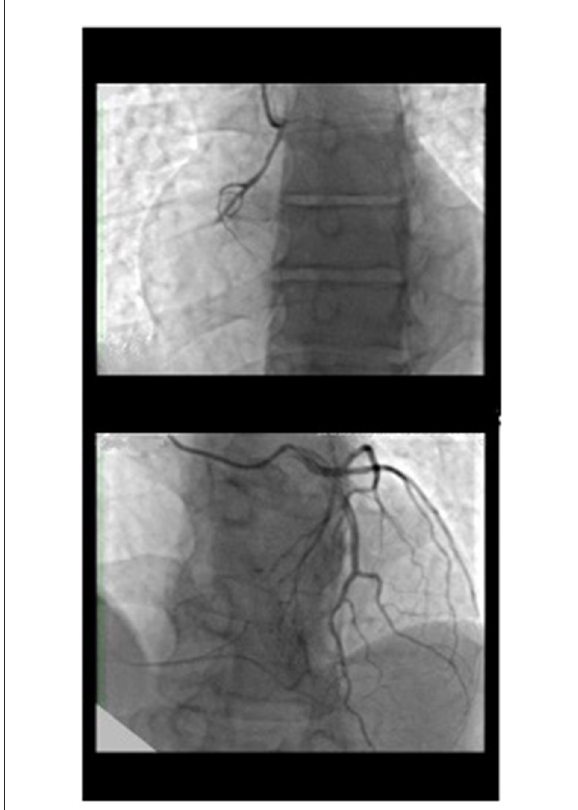
FIGURE1 Coronary angiography of the left system showed left coronary artery normally positioned without atherosclerotic disease with rentrop III heterocoronary collateral circulation toward the right coronary artery, which has an anomalous origin on the left side of the ascending aorta and chronic occlusion in the proximal atrioventricular